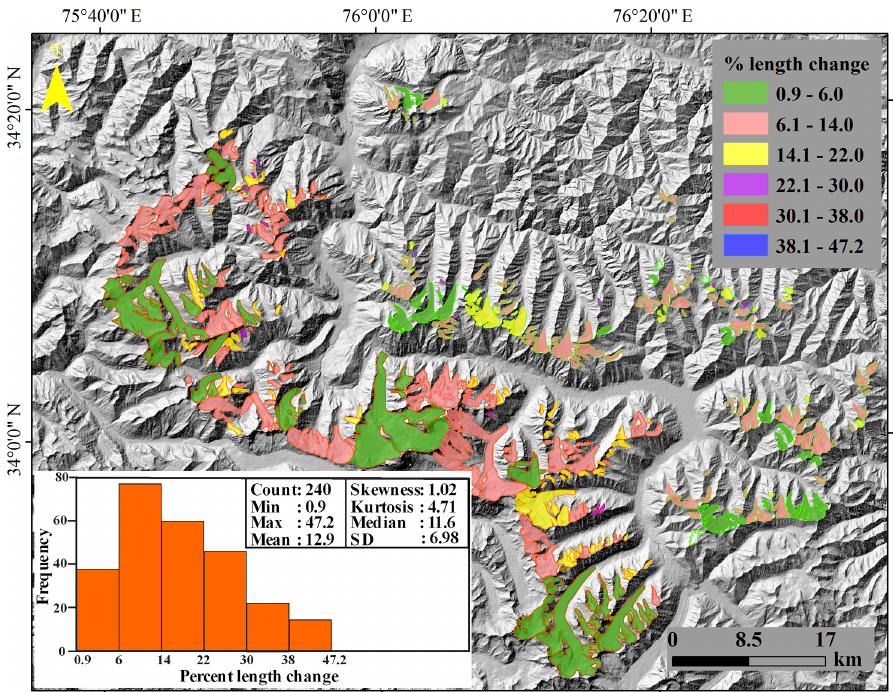
Figure 7. Percentage of length change of the glaciers in the SSB during the period 1971–2017. Frequency distribution histogram showing that majority of the glaciers have undergone length change in the range of